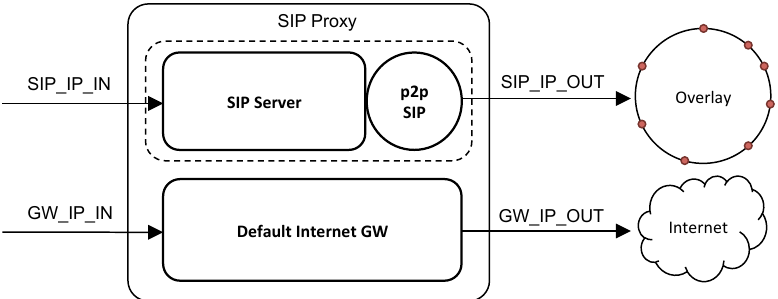
Figure 17. CNN high-level architecture (SIP Proxy and Internet gateway are